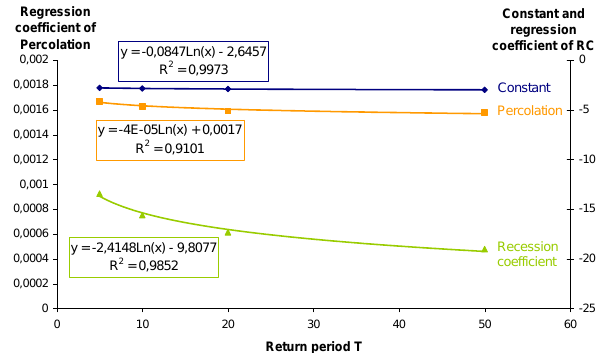
Fig. 2. Constant and regression coefficients of the global model plotted against the return period. A logarithmic relationship can be fitted to link the constant and regression coefficients to the return period.